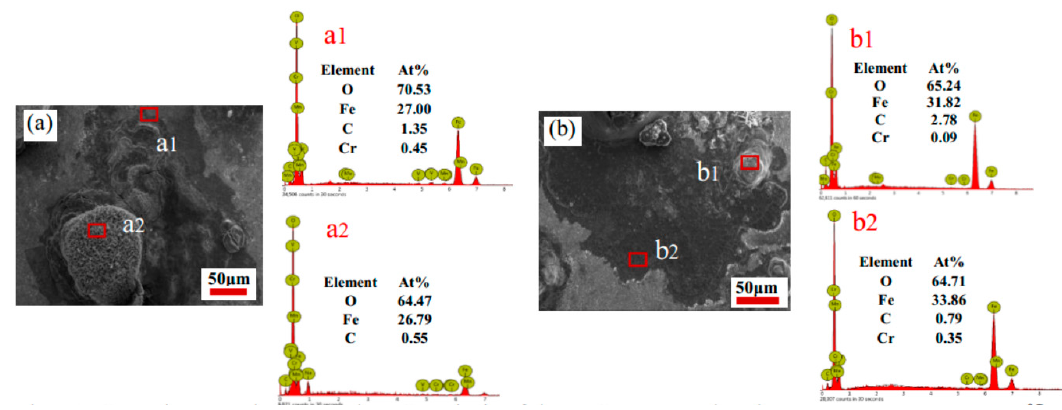
Figure 14. Corrosion morphology and energy disperse spectroscopy (EDS) analysis of the 35CrMoV steel at the same temperature (850 °C) and at different strain rates: ( a ) 0.01 s − 1 ; and ( b ) 10 s − 1 .